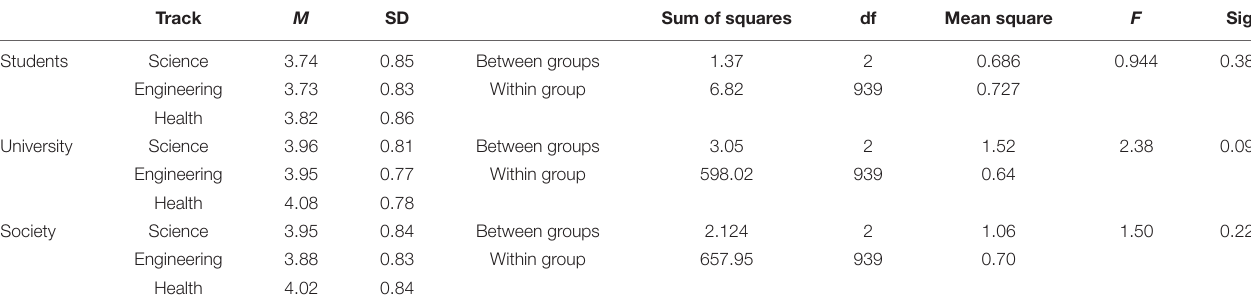
TABLE 7 | ANOVA test with track and faculty members’ responsibilities toward students, university, and society. Track M SD Sum of squares df Mean square F